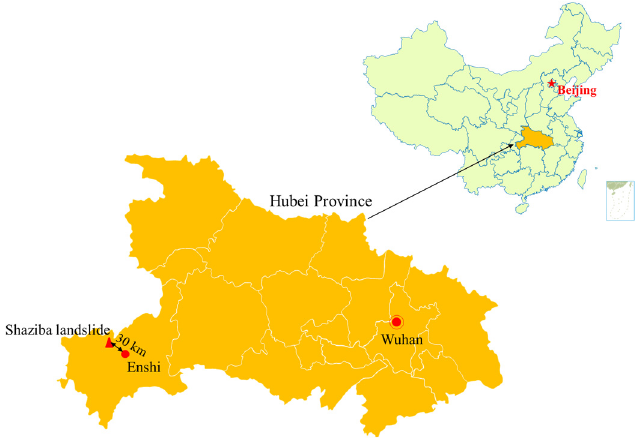
Figure 1. Location of the Shaziba landslide.